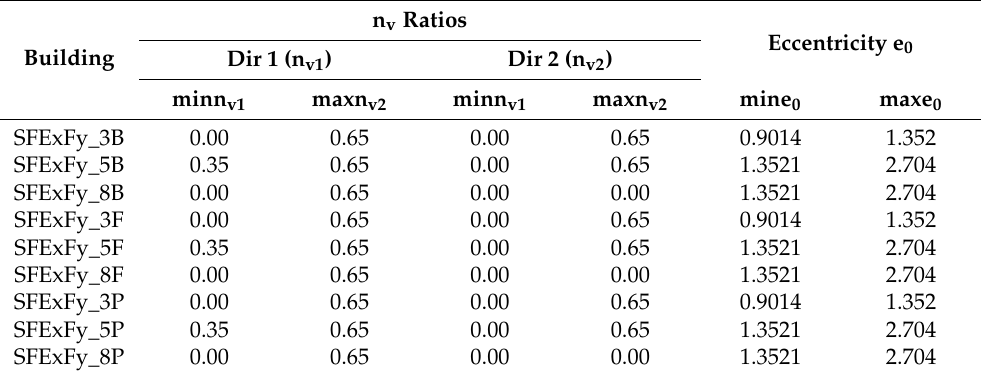
Table 11. Assumed ranges of the values of the case study buildings’ unknown structural parameters.